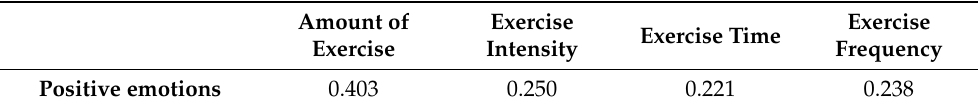
Exercise Amount of Exercise Exercise Time Exercise Intensity